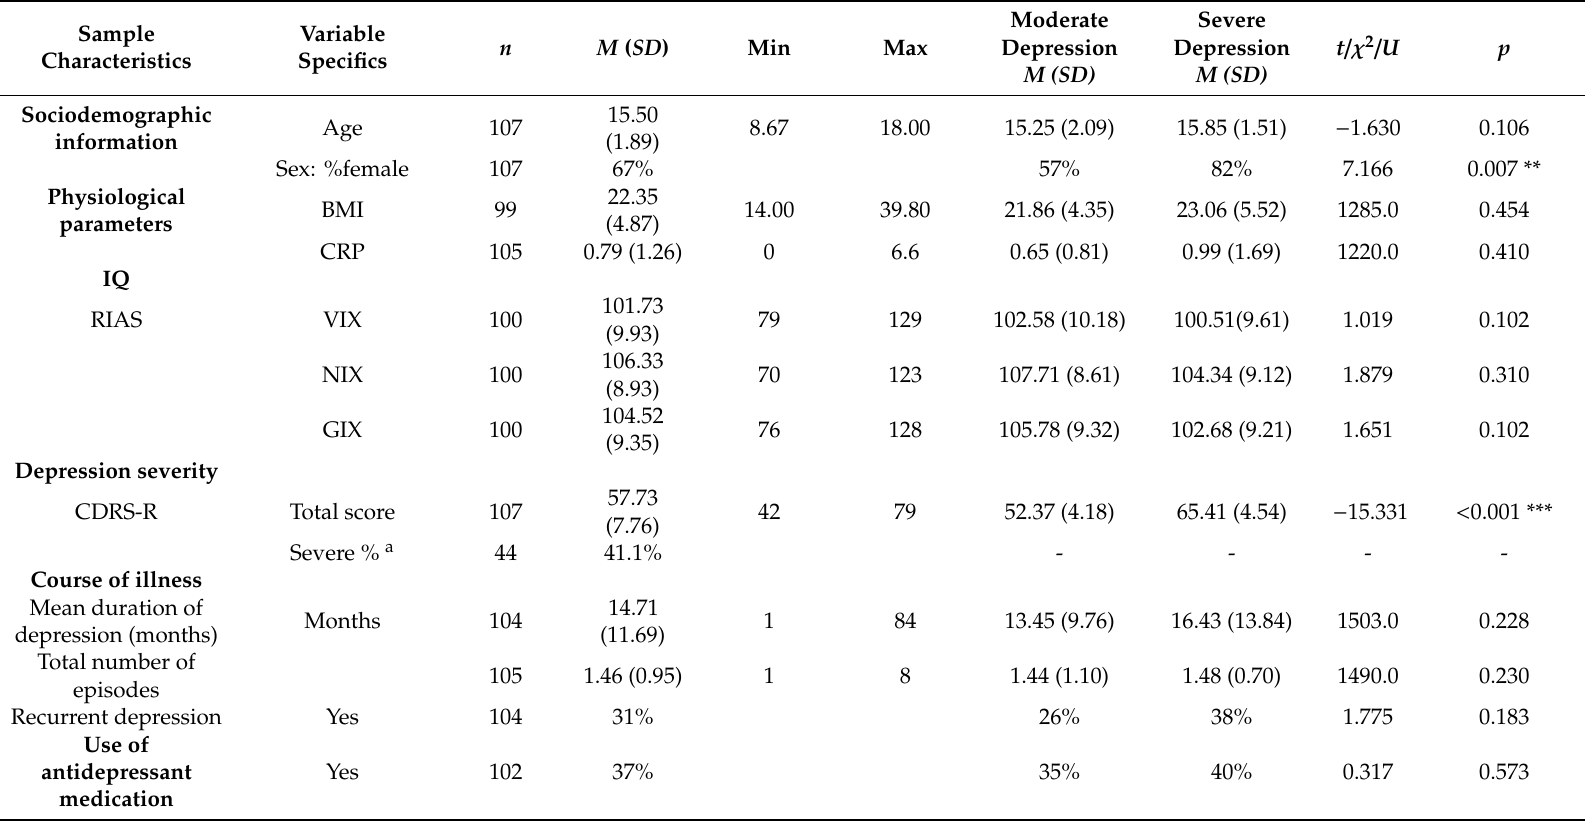
Table 1. Descriptive statistics for sociodemographic information, biological parameters, IQ,